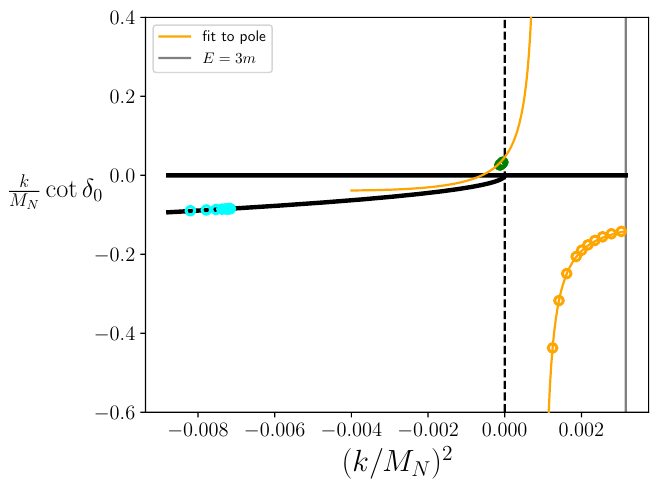
Figure 10 . s -wave phase shift as a function of the center-of-mass frame momentum for the simpli(cid:12)ed toy model describing nucleon-deuteron scattering. Parameters are M N a 0 = 20 : 56 and M 2 K iso = (cid:0) 33500. Notation as in (cid:12)gure 7. The (cid:12)t is discussed in the text. N df ; 3 ma = 6, (cid:12)gure 7(b), despite the present value of ma 0